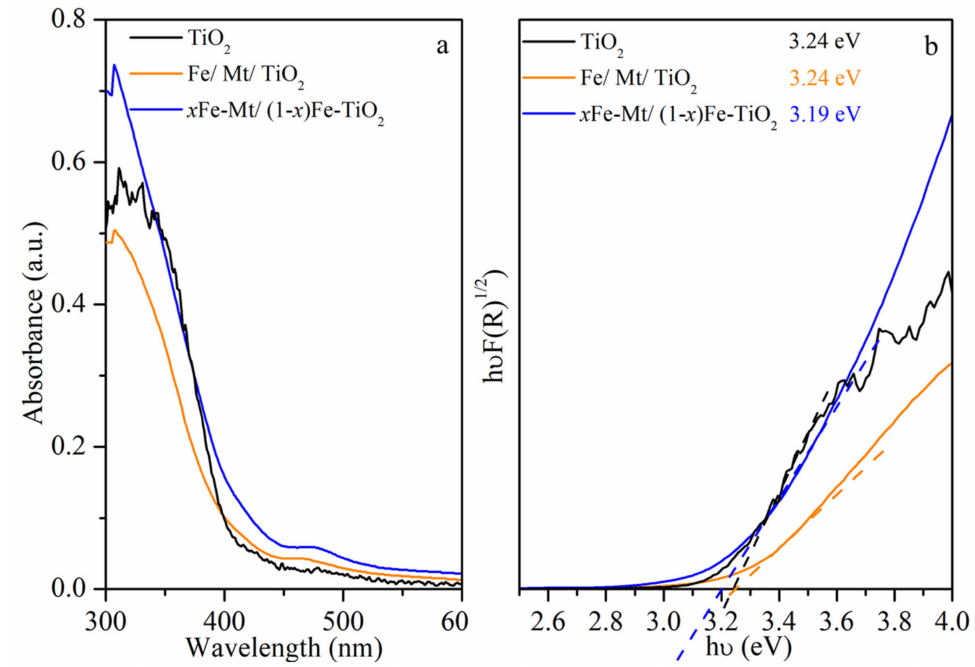
Figure 6. ( a ) DRS-UV spectra; ( b ) corresponding Tauc plots of Fe/Mt/TiO 2 and x Fe-Mt/(1 − x )Fe- TiO 2 synthesized at 70 ◦ C.